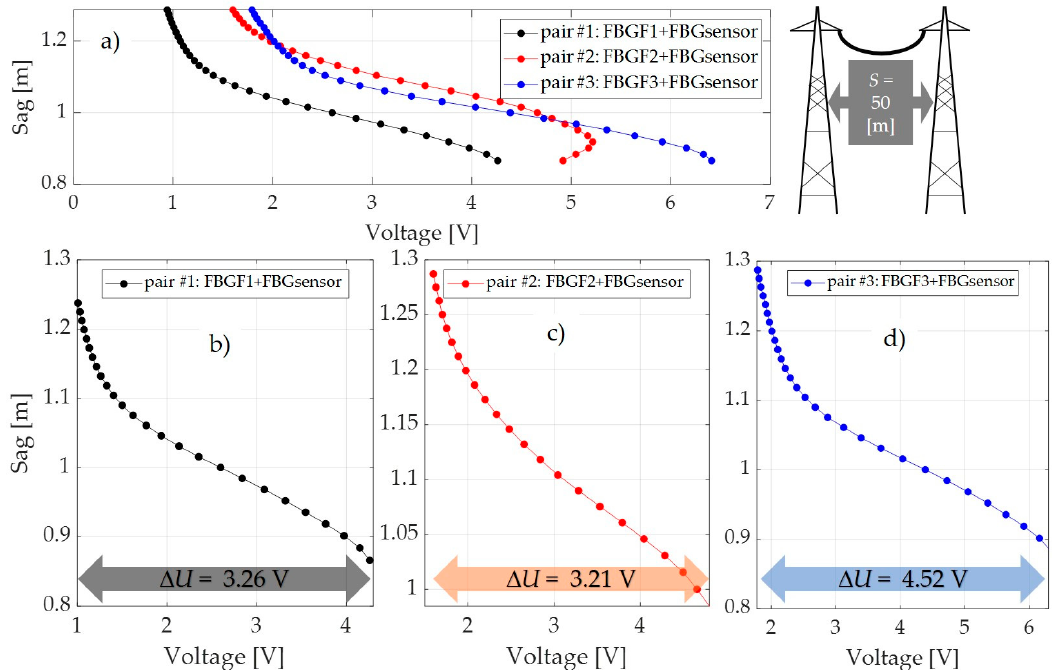
Figure 21. Results of power line sag value as a function of voltage measured by a photodetector for power line #1: ( a ) sag characteristics for three pairs of FBG structures; ( b ) sag dependence on the measured voltage on the photodetector for pair #1; ( c ) sag dependence on measured voltage on the photodetector for pair #2; ( d ) sag dependence on measured voltage on photodetector for pair #3.